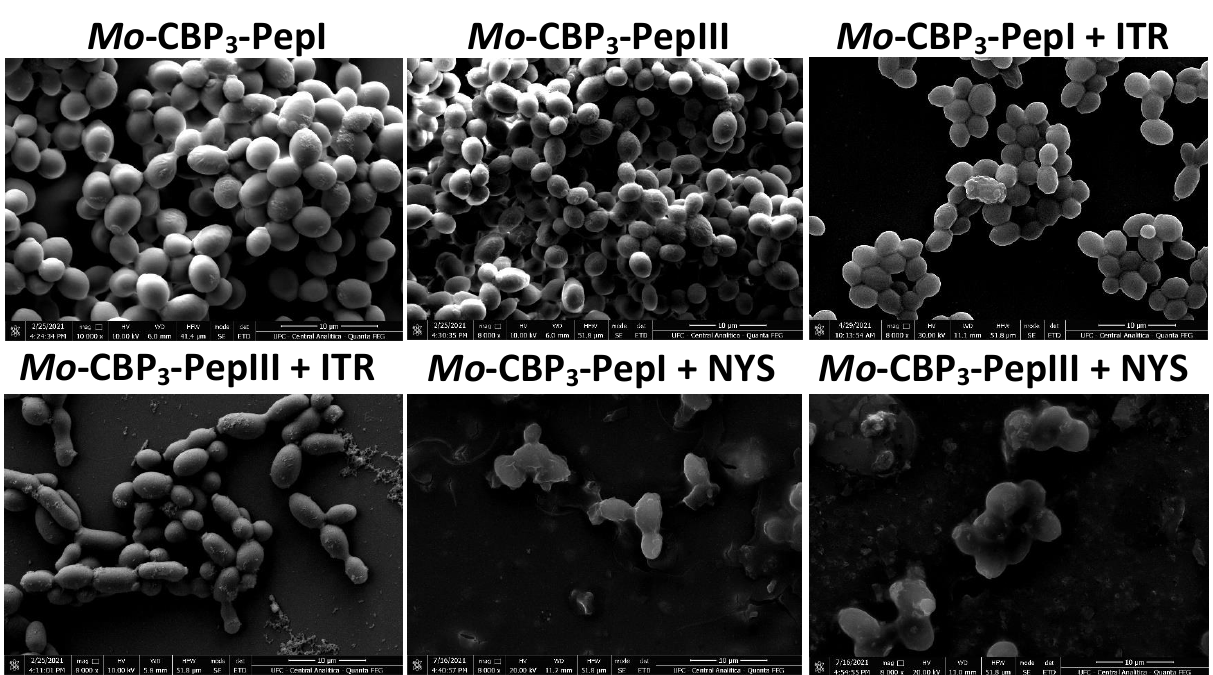
Figure 2. SEM images showing C. albicans biofilms after treatment with ITR, NYS, Mo -CBP 3 -PepI, Mo -CBP 3 -PepIII, and their combinations. Control: DMSO-NaCl solution.